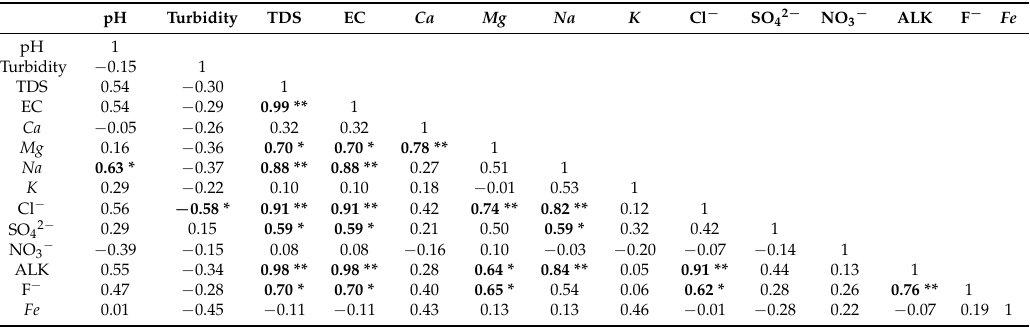
Figure 6. Mean concentrations and proportion of major ionic constituents ( Na , K , Fe , Ca , Mg , Cl − , SO 42 − , NO 3 − ) in the water brands. Data for each brand are the mean values of the total samples ( n = 30). Table 4. Correlation matrix for the physico-chemical water quality